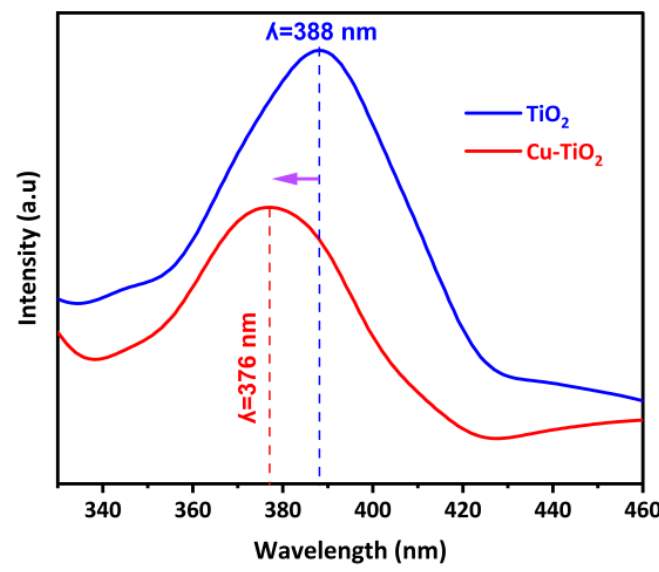
Figure 5. Photoluminescence of as-made plain TiO 2 and Cu-TiO 2 materials.